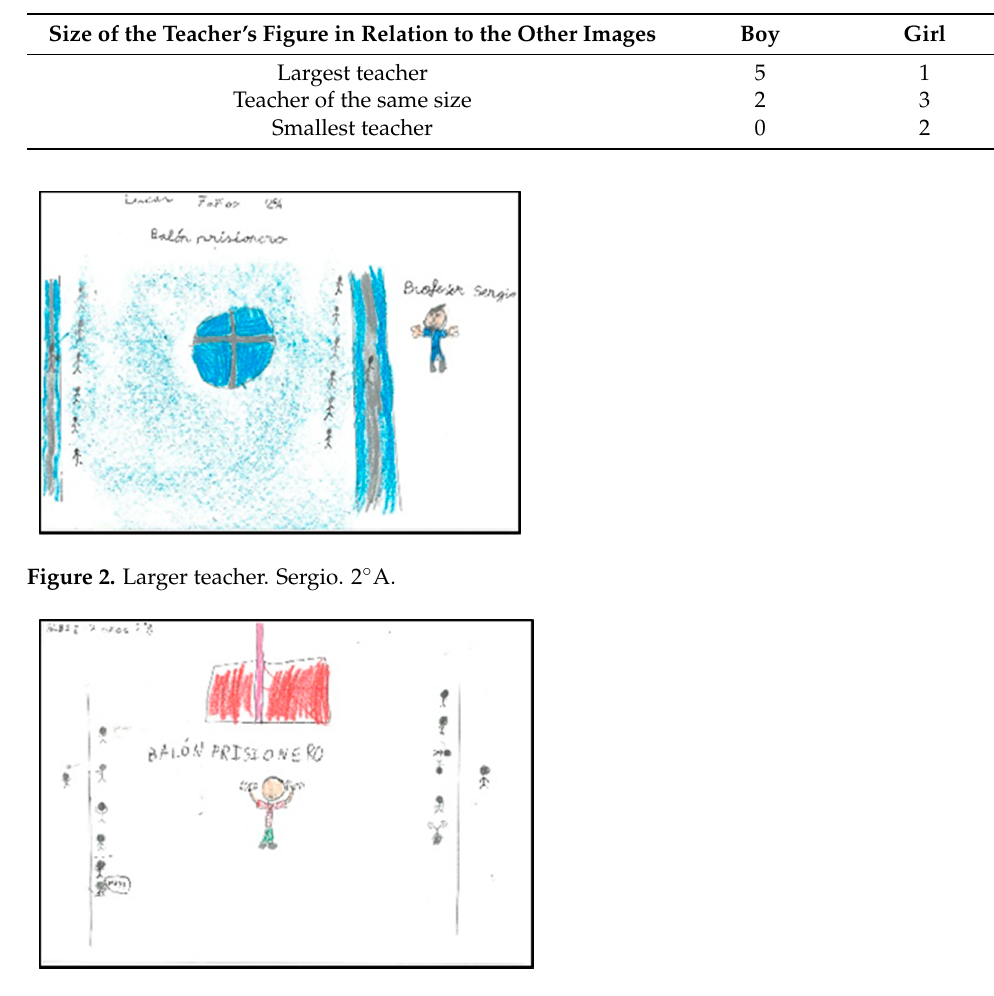
Figure 3. Teacher at a larger size. Alba. 2°A.